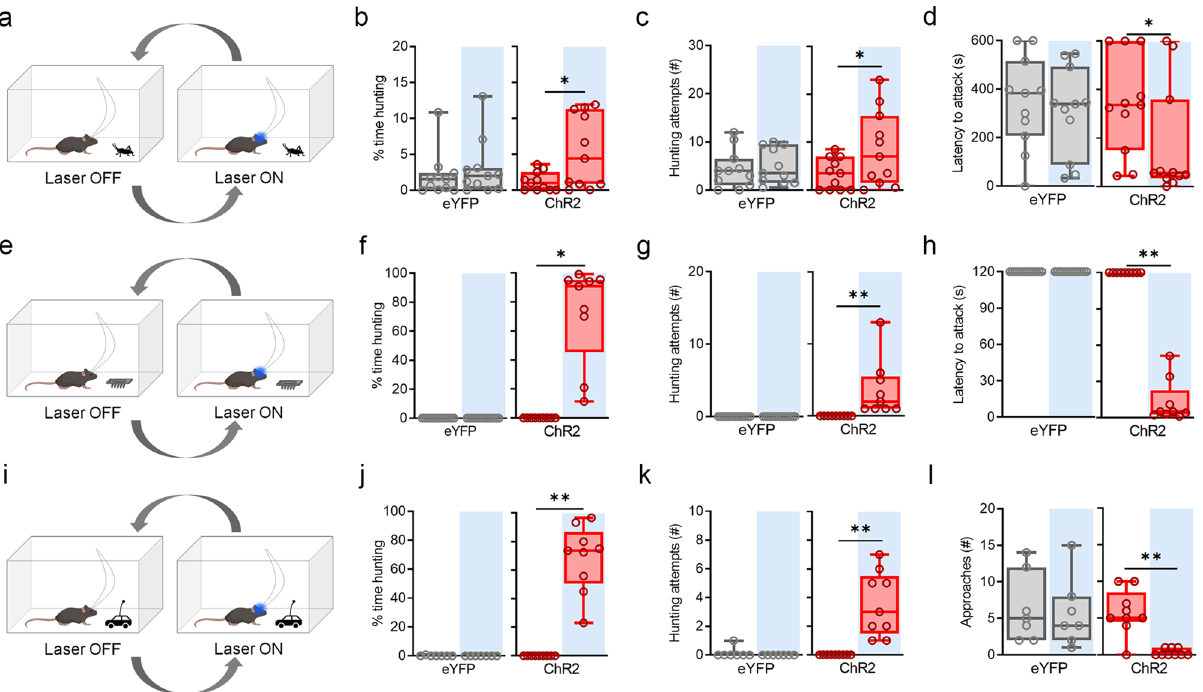
Figure 4. BF GAD2+ activation promotes hunting of live and artificial prey. ( a ) Design of live cricket prey hunting assay used in ( b – d ). ( b ) Percent time hunting, defined as the time spent pursuing and capturing the cricket. ChR2, Wilcoxon signed rank test, W = 43, *p < 0.05. ChR2, n = 11; eYFP, n = 11. ( c ) Number of hunting attempts. ChR2, paired t-test, t 10 = 2.36, *p < 0.05. ChR2, n = 11, eYFP, n = 11. ( d ) Latency to attack. ChR2, Wilcoxon signed rank test, W = − 43, *p < 0.05. ( e ) Design for artificial prey hunting assay used in ( f – h ). Artificial prey consisted of a small toy (robobug) that is propelled by vibration. ( f ) Percent time hunting. ChR2, Wilcoxon signed rank test, W = 45, **p < 0.01. ChR2, n = 9; eYFP, n = 14. ( g ), Number of hunting attempts. ChR2, Wilcoxon signed rank test, W = 45, **p < 0.01. ( h ) Latency to attack. ChR2, Wilcoxon signed rank test, W = 45, **p < 0.01. ( i ) Design of the interactive artificial prey assay used in ( j – l ). Interactive prey consisted of a toy car remote-controlled by